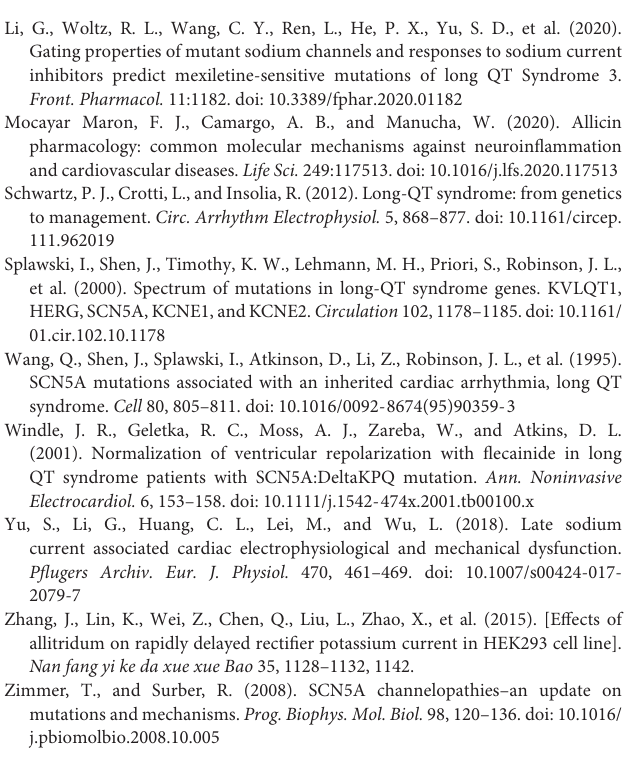
Supplementary Figure 1 | Steady-state activity (SSA) of I Na curves. Supplementary Figure 2 | Steady-state inactivity (SSI) of I Na curves. Supplementary Figure 3 | Intermediate-state inactivation (ISI) of I Na curves. Supplementary Figure 4 | Closed-state inactivity (CSI) of I Na